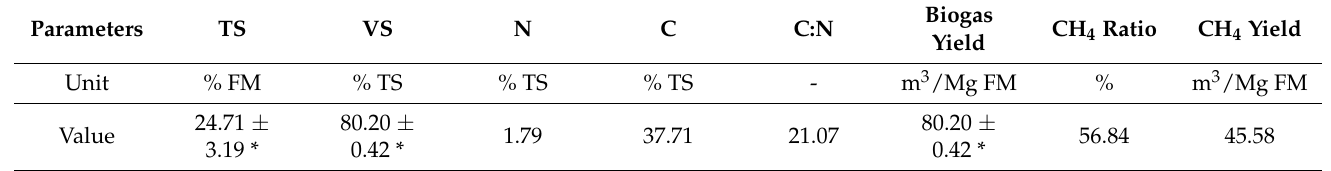
Table 5. The initial parameters and methane productivity of solid fraction of cow manure.